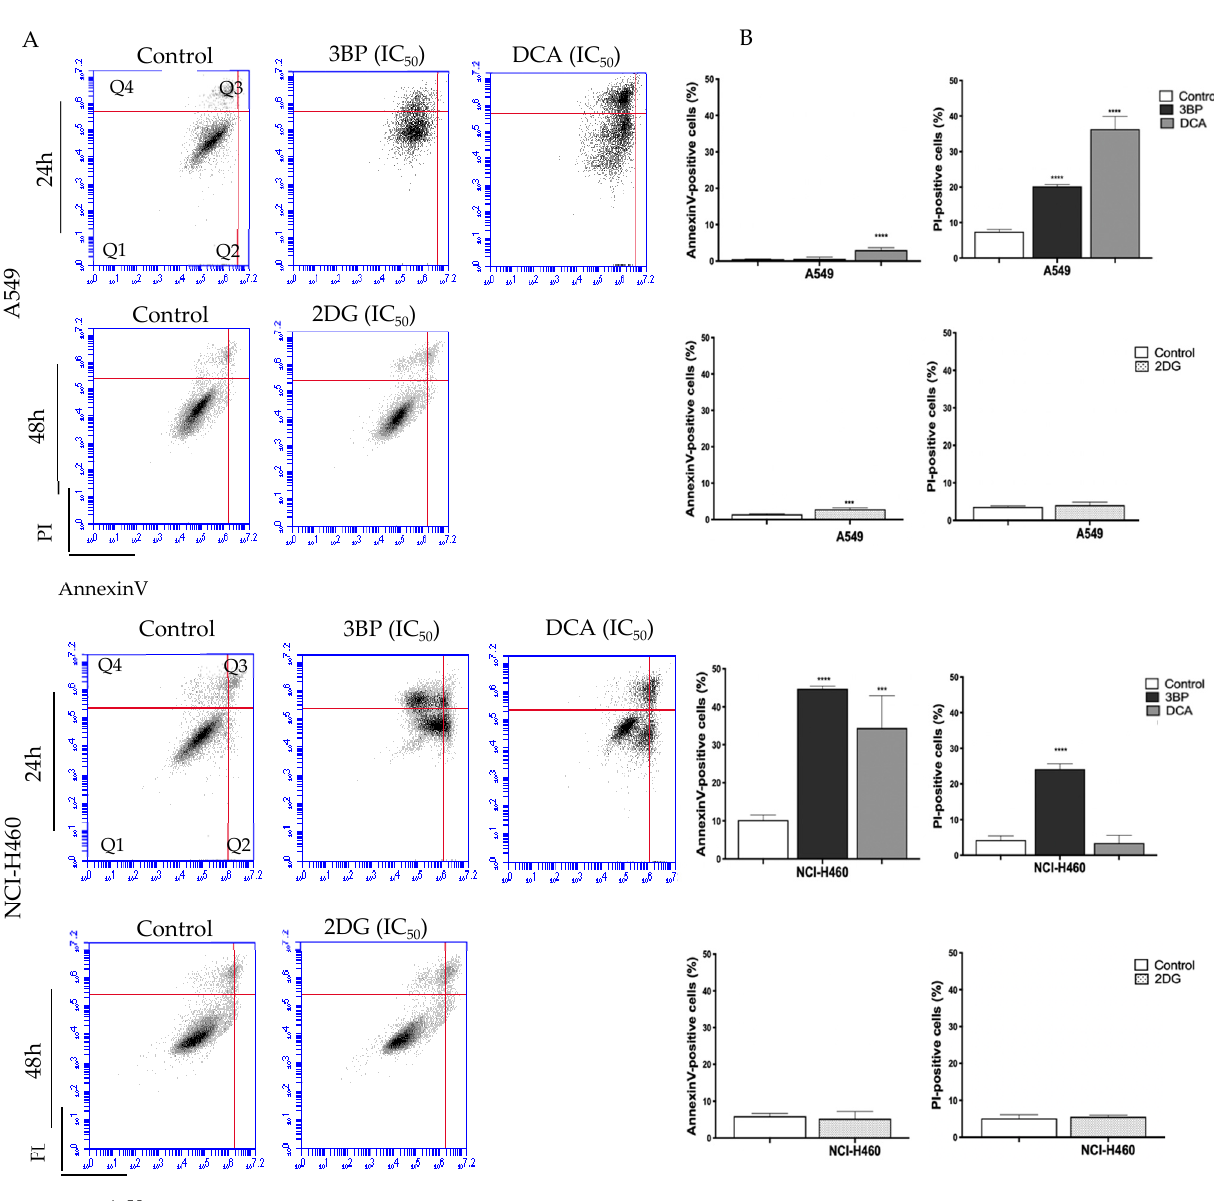
Figure 2. Effect of GIs on cell death after 24 h of treatment with 3BP and DCA or after 48 h with 2DG. Representative cytograms ( A ) and quantification of Annexin V- and PI-positive cells ( B ) are shown for A549 (top) and NCI-H460 (bottom) cell lines. The quadrants (Q) were defined as Q1 = live (Annexin V- and PI-negative), Q2 = early stage of apoptosis (Annexin V-positive/PI-negative), Q3 = late stage of apoptosis (Annexin V- and PI-positive) and Q4 = necrosis (Annexin V-negative/PI-positive). *** p < 0.001; **** p < 0.0001 compared to untreated cells (control).